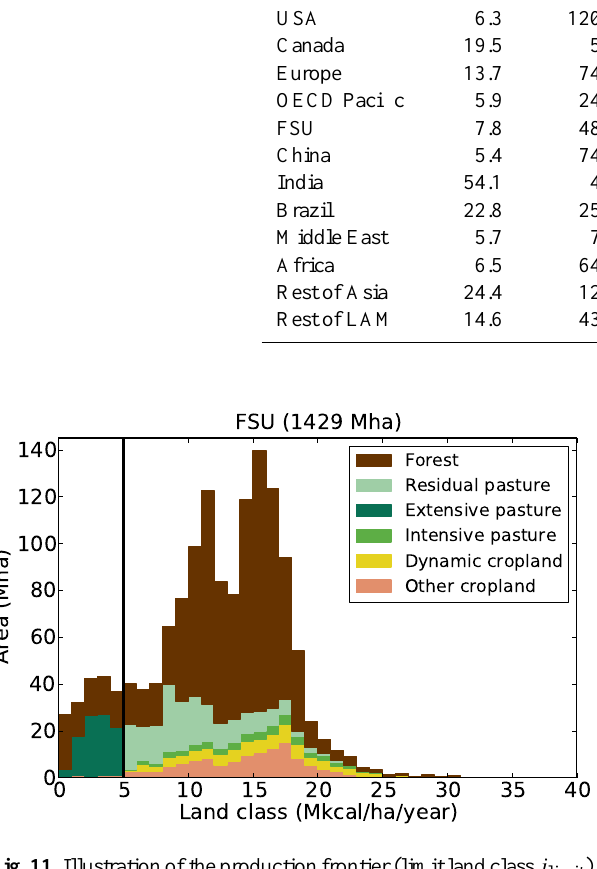
Fig. 11. Illustration of the production frontier (limit land class j limit ) on the histogram of the land area classes of potential yield in the former Soviet Union (black vertical bar). The intensive livestock system is located on the right of this frontier, and the extensive sys- tem on the left. When the profit of the intensive system increases relatively to the extensive one, j limit decrease to lower fertile land classes (the black vertical bar moves to the left in the figure) and the corresponding extensive pastures becomes part of the intensive system. In the opposite case, the frontier moves to more fertile land classes and the extensive system increases at the expense of the in- tensive one. For more details, see Sect. 2.4 and Eq. (23) in Sect. 4.3. X-axis in GJha − 1 yr − 1 ranges from 0 to